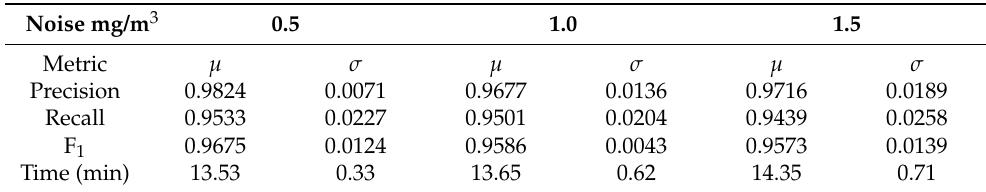
Figure 6. The red zone pollution estimation in the Orthogonal Passage scenario performed using the BREEZE approach with Gaussian noise of 0.5 mg/m 3 . The grey cells are ground truth, the red cells are True-Positive, the green cells are False-Positive, and the blue cells are obstacles. Table 1. The data gathered in the Orthogonal Passage scenario for three different noise levels (0.5, 1.0, and 1.5 mg/m 3